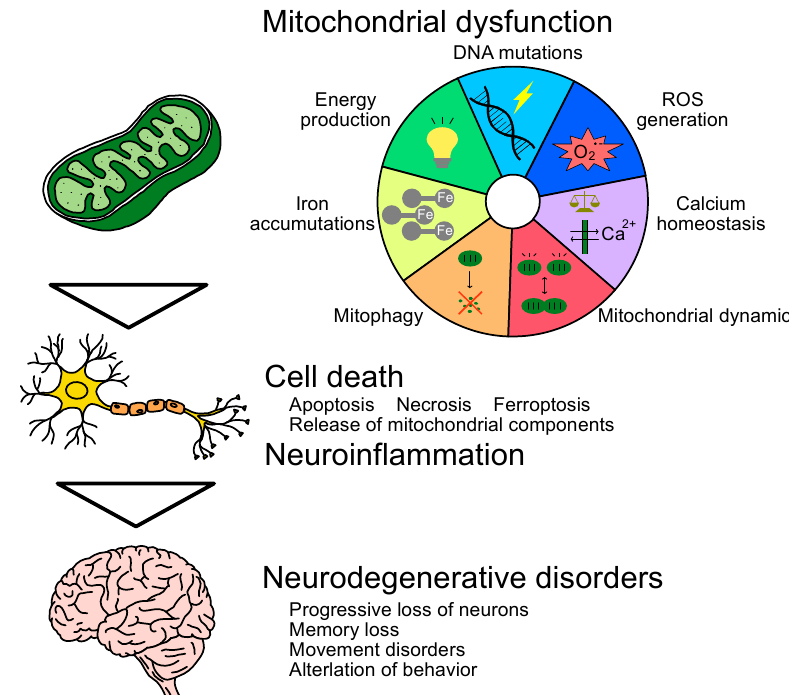
Figure 1. Multifactorial effects of mitochondrial dysfunction in the process of neurodegenerative disorders.